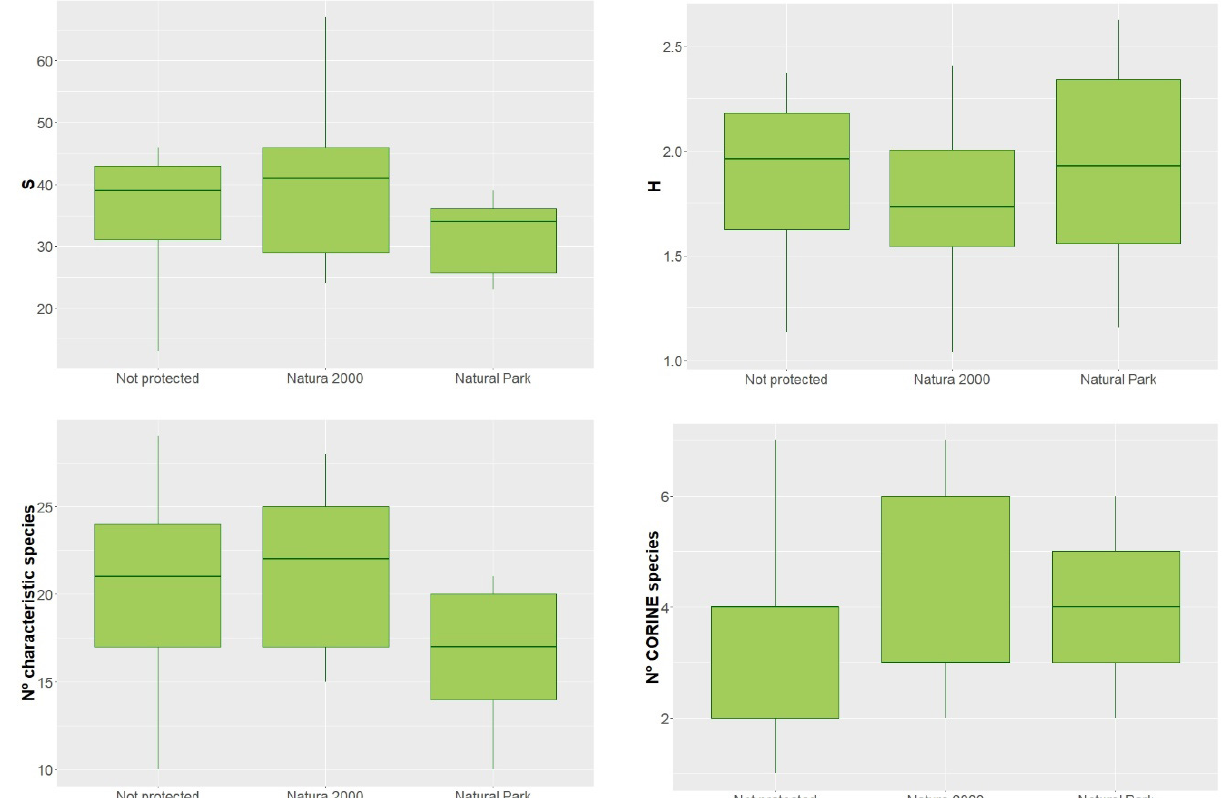
Figure 3. Conservation indicators of the sessile oak forest for each protection category.